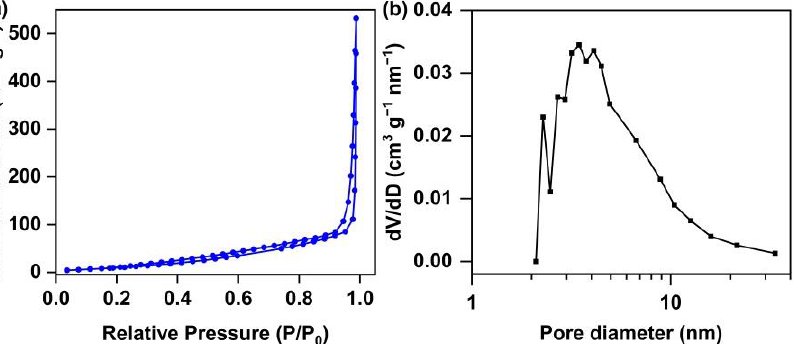
Figure 3. The nitrogen isothermal adsorption desorption curves ( a ) and pore size distribution ( b ) of PAnTPE.